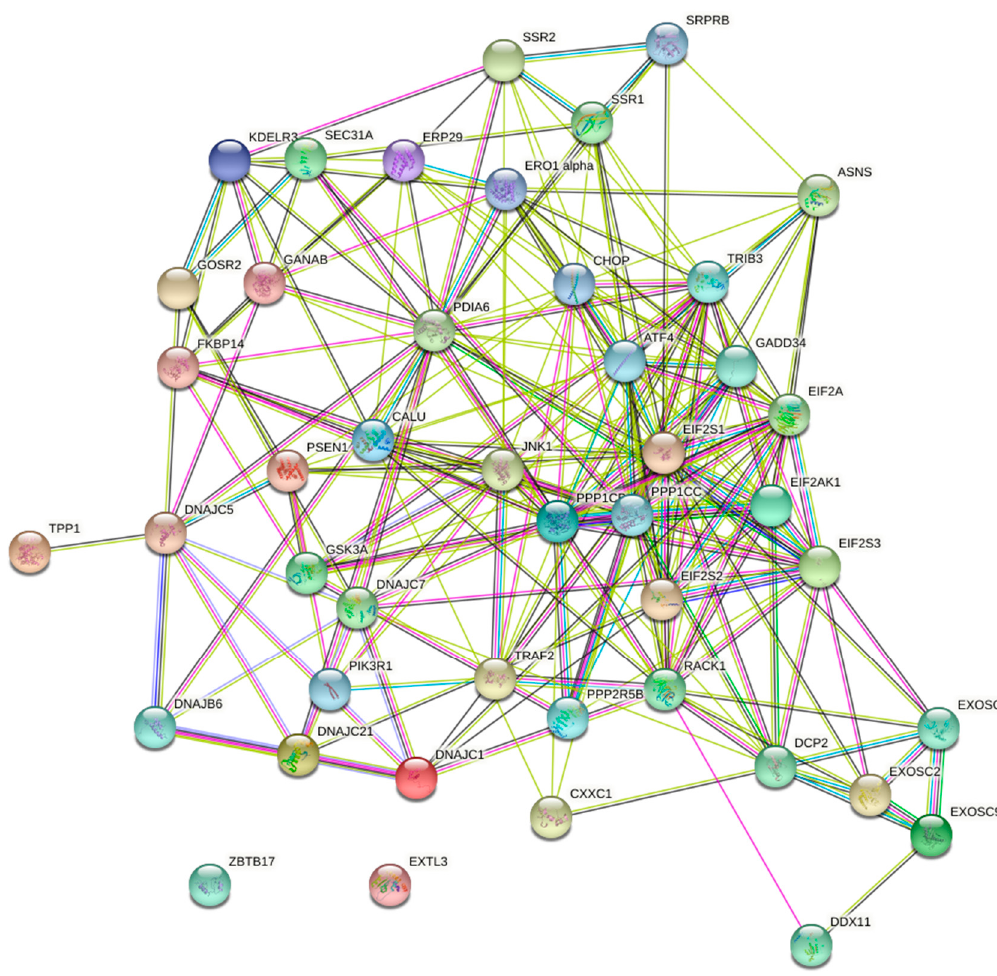
Figure 3. An interconnected gene map of UPR-associated genes with prognostic value in HCC.